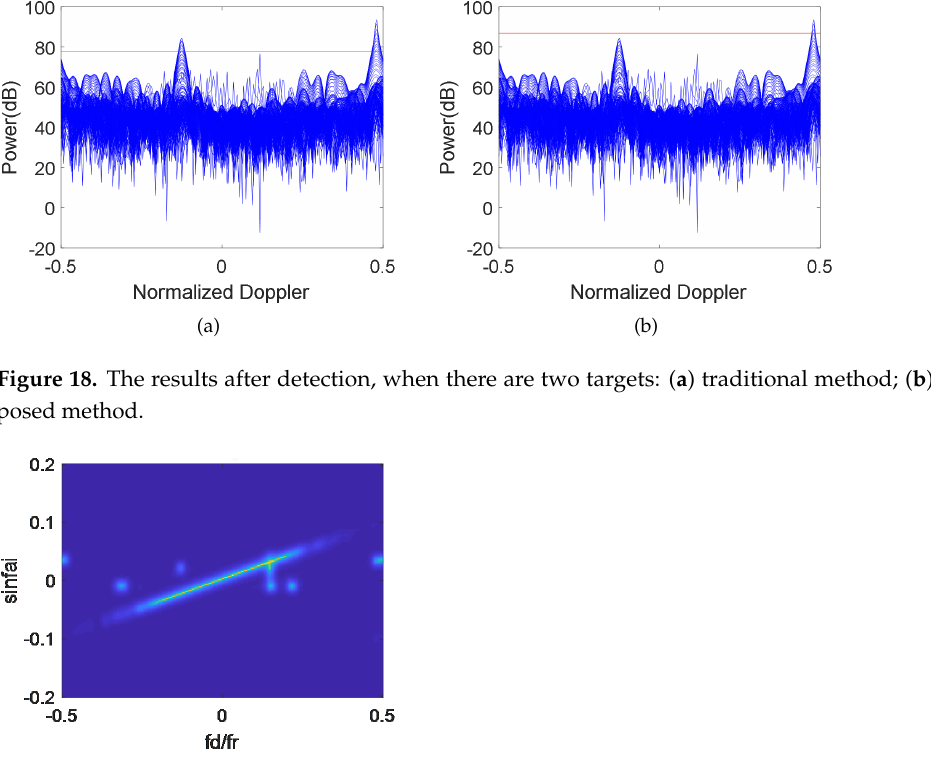
Figure 19. The Capon of several targets.